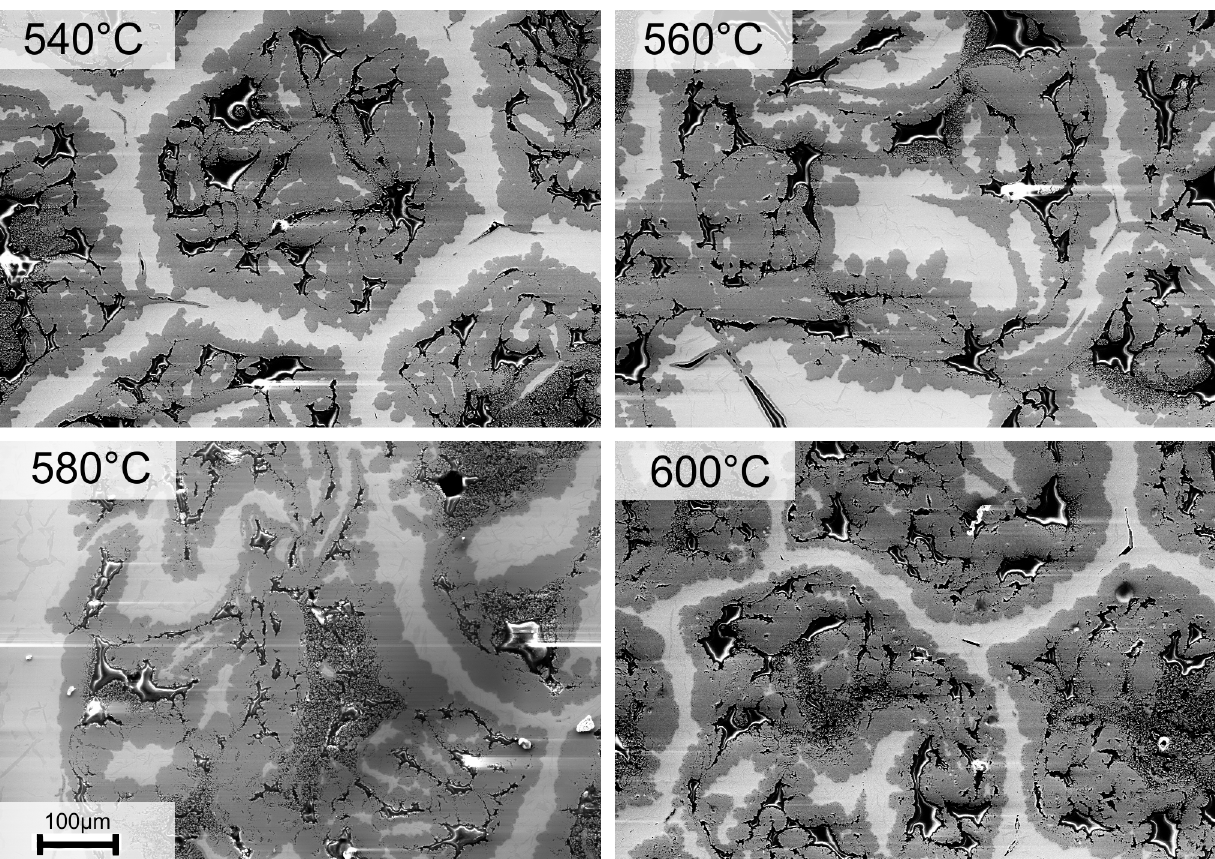
Figure 2. Microstructure of the wires after isothermal heat treatments until consumption of all Al at 540 °C/220 h, 560 °C/180 h, 580 °C/116 h, 600 °C/12 h. SE images. Bright: Ti, dark: TiAl , black: 3